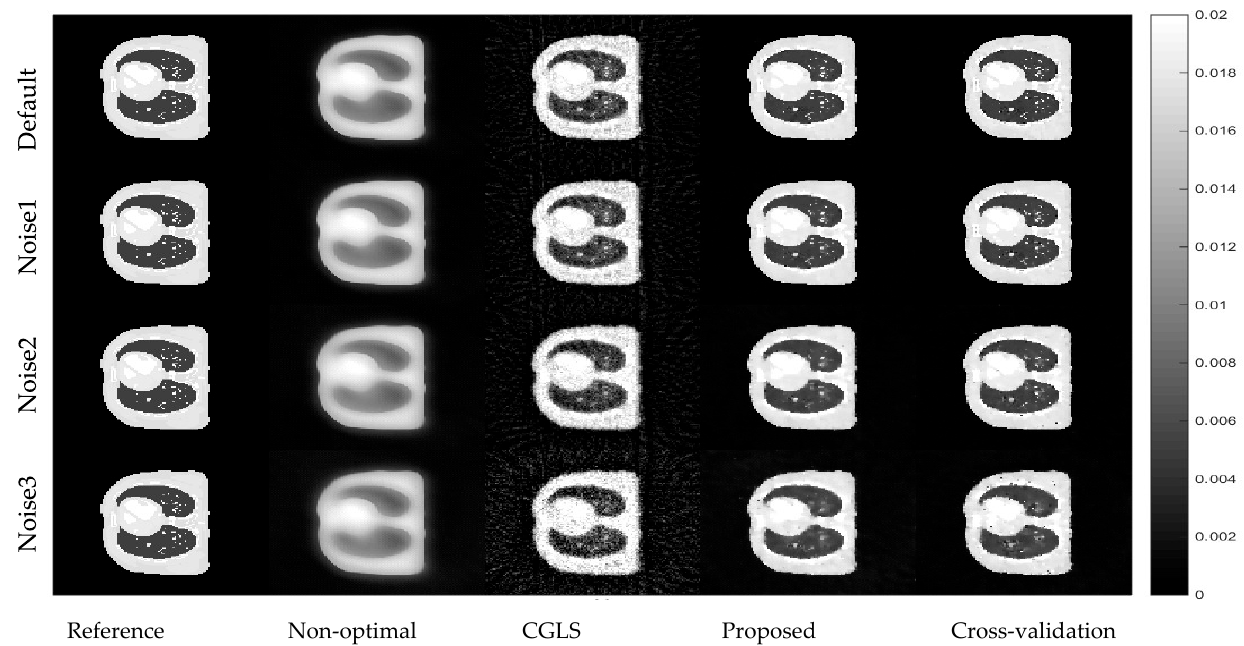
Figure 7. Reconstruction results from the projection data with different levels of noise. The display window is [0–0.02].